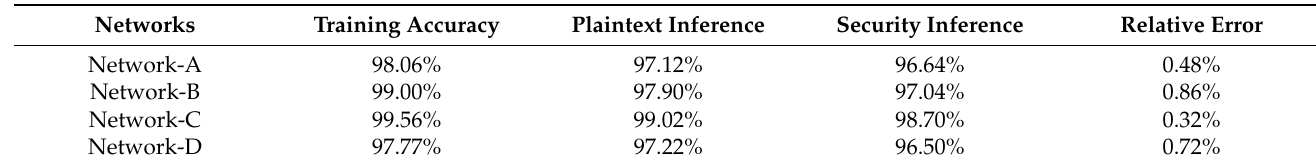
Table 6. Comparison of accuracy under secure prediction and